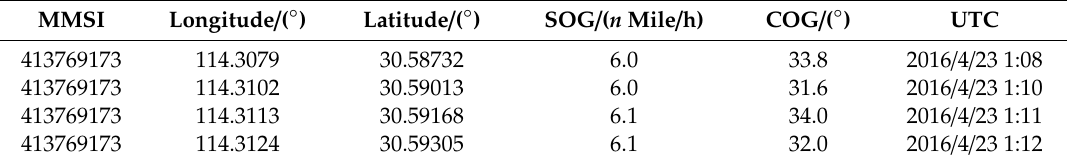
Table 1. Fragment of automatic identification system (AIS) data: Maritime Mobile Communication Service Identification (MMSI) code is a unique identifier for ships. SOG is the speed of the ship to the ground, COG is the heading of the ship to the ground, and UTC is the current time. MMSI Longitude / ( ◦ ) Latitude / ( ◦ ) SOG / ( n Mile /